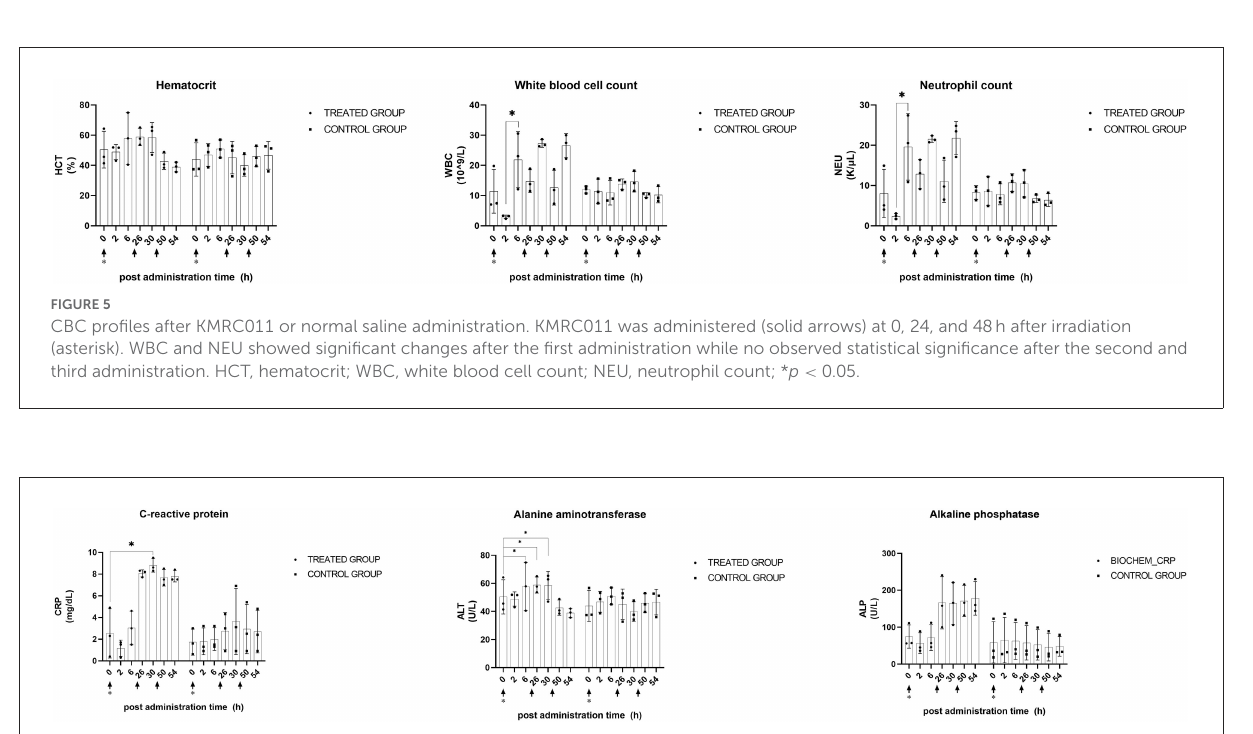
FIGURE6 Plasma biochemistry profiles after KMRC011 or normal saline administration. KMRC011 was administered (solid arrows) at 0, 24, and 48h after irradiation (asterisk). Only the treated group showed significant changes in plasma biochemistry profiles. ALT significantly changed after the first and second administration and CRP significantly changed after the second administration. ALP did not show significant changes after the administration. CRP, C-reactive protein; ALT, alanine aminotransferase; ALP, alkaline phosphatase; CRP, C-reactive protein; * p <